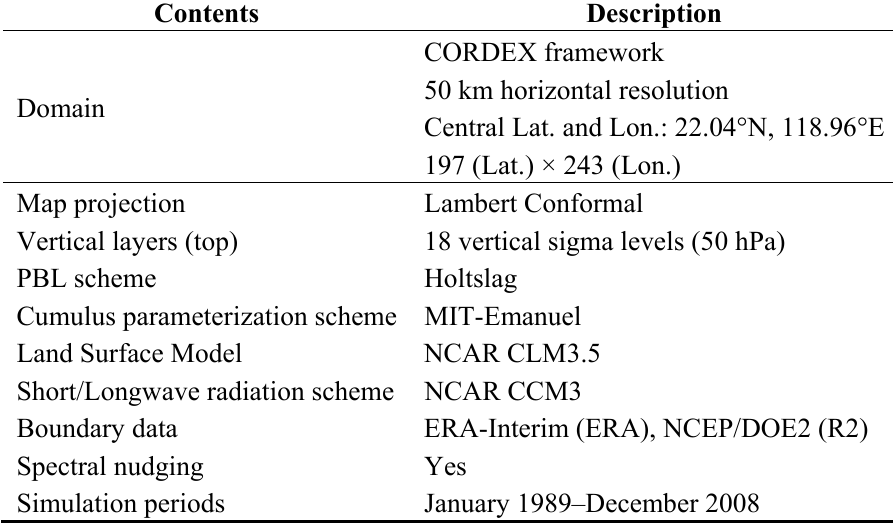
Table 1. Model configuration used in this